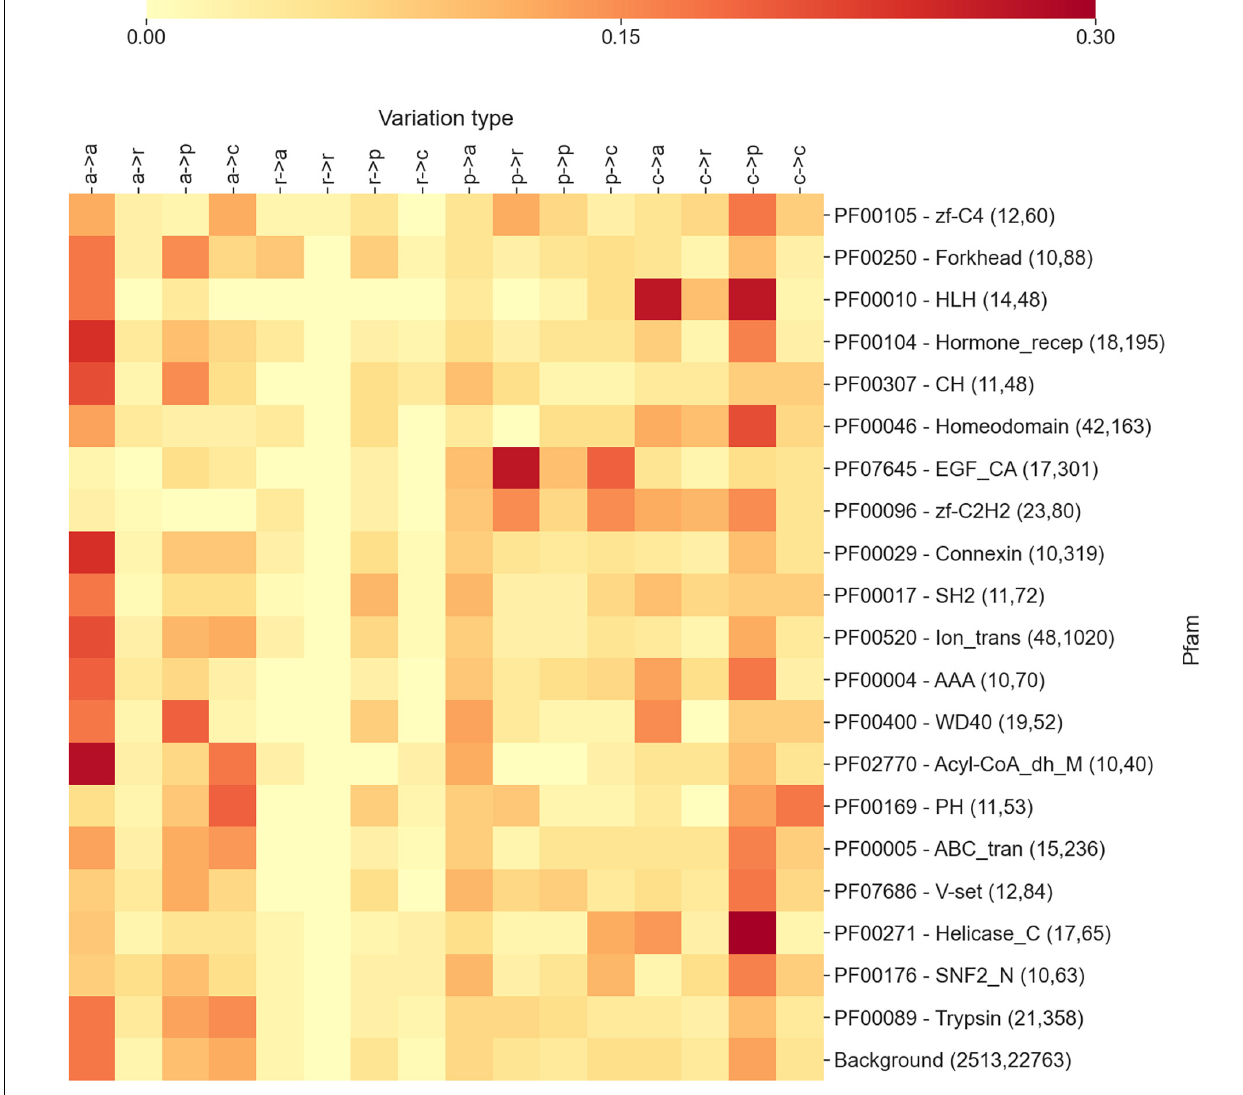
FIGURE 1 | The heatmap reporting the frequency of each variation type as observed within the 20 Pfam entries mostly associated with diseases. For each Pfam, the numbers within parentheses indicate the number of proteins and disease-related variations covered. In variation types, labels are as follows: a, apolar; r, aromatic; p, polar; and c, charged. Mean and median Kullback–Leibler divergences (Eq. 2) between individual Pfam distributions and the background are 2.1 and 2.1 bits,